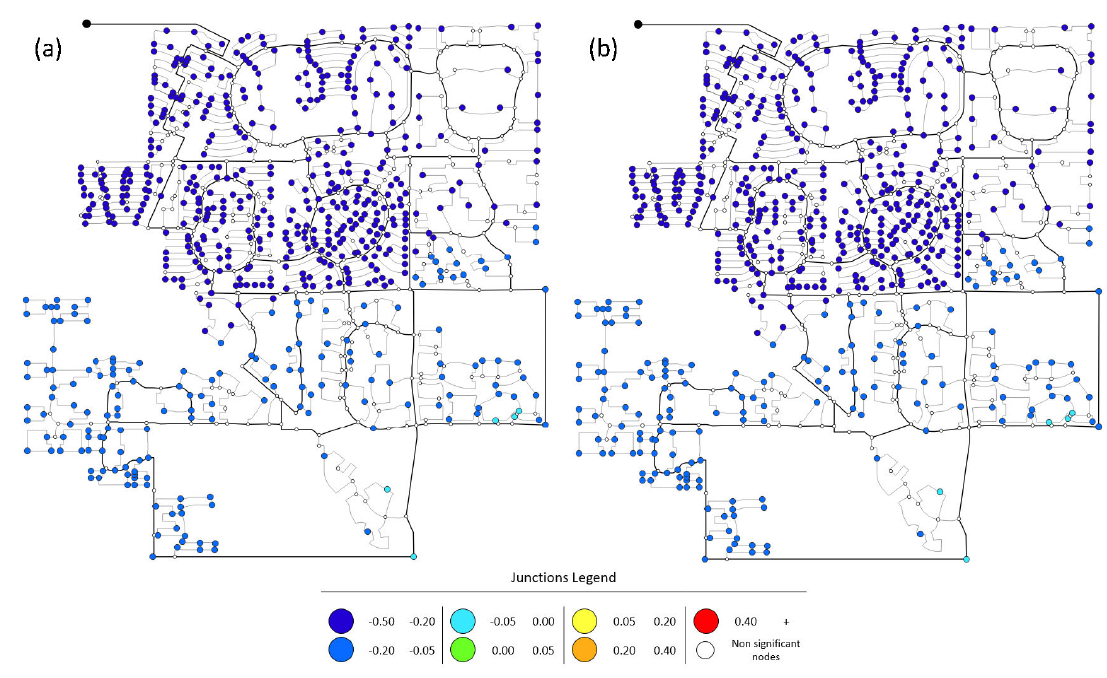
Figure 4. Graphs containing the local pressure head surplus index, for the peak coefficient P c = 1.75.